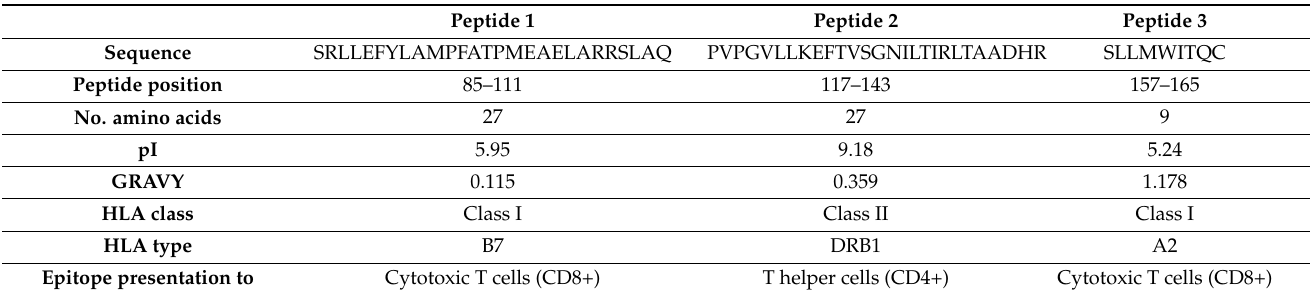
Table 3. Characteristics of the NY-ESO-1 epitopes.